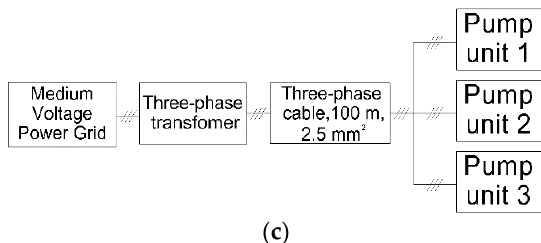
Figure 8. Structure of the considered electric system: ( a ) case 1; ( b ) case 2; ( c ) case 3.